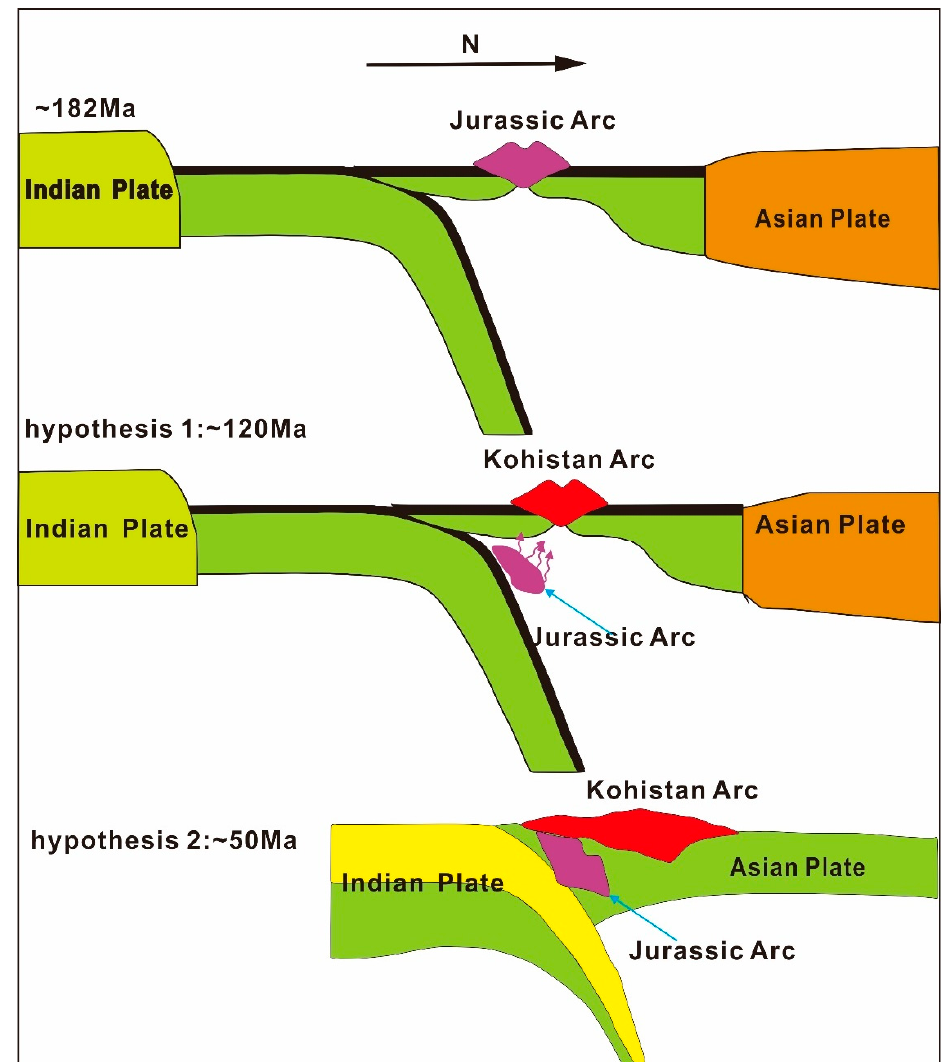
Figure 6. Hypotheses for the origin of Jurassic zircon grains within the chromitite of the Jijal complex. Hypothesis 1: The Jurassic Kohistan arc was formed during the Jurassic subduction of the Tethyan lithosphere, which was subducted into the mantle during the second stage subduction responsible for the origin of the Early Cretaceous Kohistan arc. The Jurassic zircon grains of crustal materials (i.e., granite) were recycled to the mantle source of the Early Cretaceous arc. Hypothesis 2: The Jurassic and Cretaceous Kohistan arcs were formed by the Jurassic and Cretaceous subduction of the Neo-Tethyan lithosphere, respectively, while the Jurassic arcs (mostly the lower part, as the upper counterparts are easily eroded) probably now underlay the Cretaceous arcs caused by their accretion to the Asian margin and subsequent Indian–Asian